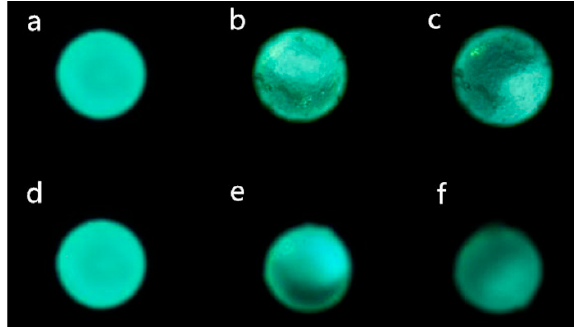
Figure 8. Images of MIPs in ( a – c ) milk and ( d – f ) pork. (for a – c and d – f , the concentrations of bacteria were 0, 10 3 , and 10 5 CFU mL − 1 ).